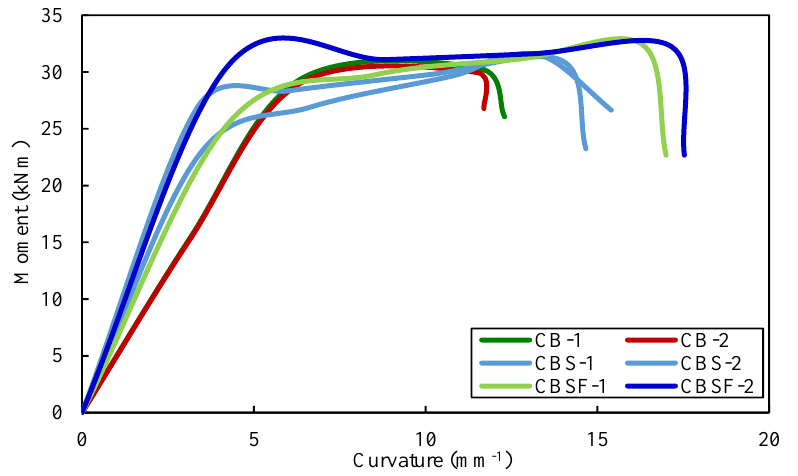
Figure 13. Moment – curvature curves of the composite CFS beams. Figure 13. Moment–curvature curves of the composite CFS